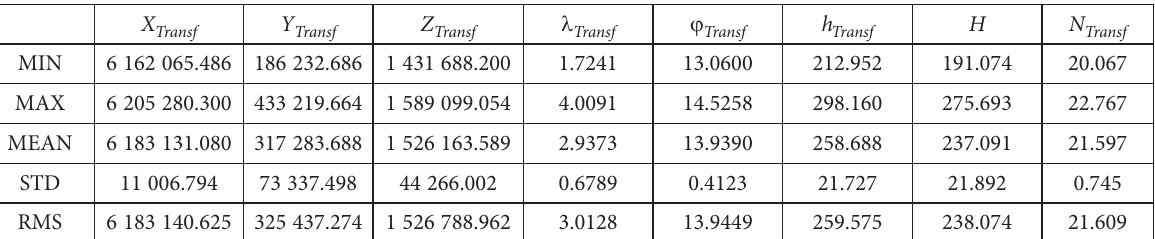
Table 8. Statistics of coordinates and geometric geoid after transformation